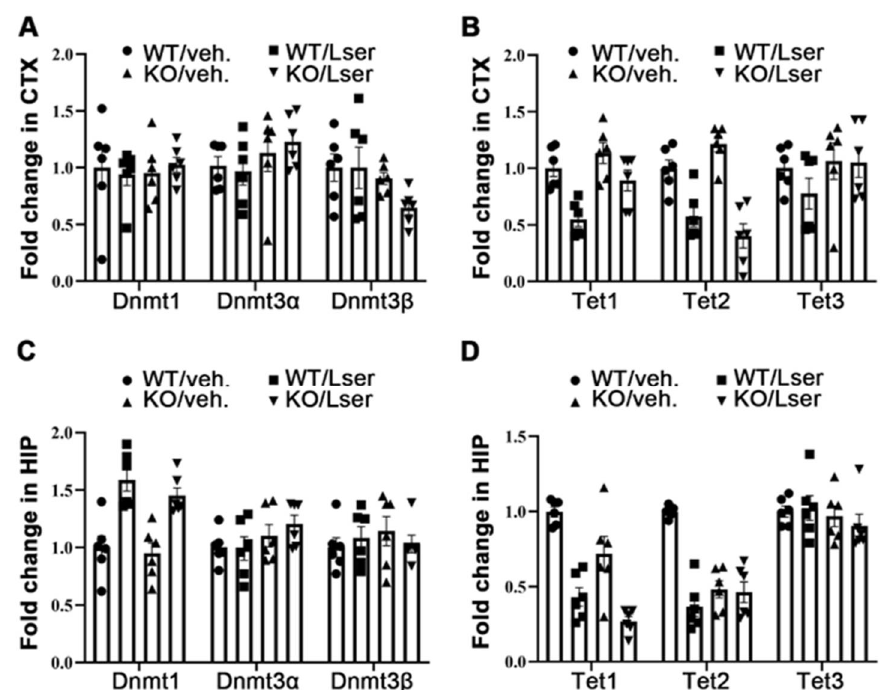
Figure 4. Oral administration of L-serine regulated mRNA level of Dnmt and Tet in GHRH-KO mice and wild type controls. GHRH-KO mice and age-matched wild type controls were subject to L-serine oral administration for 12 weeks. The mice were euthanized and tissues were collected for RNA extraction. ( A ) Expression of Dnmt in the cerebral cortex. ( B ) Expression of Tet in the cerebral cortex. ( C ) Expression of Dnmt in the hippocampus. ( D ) Expression of Tet in the hippocampus. n = 6 mice per group. Data represent means ± SEM.